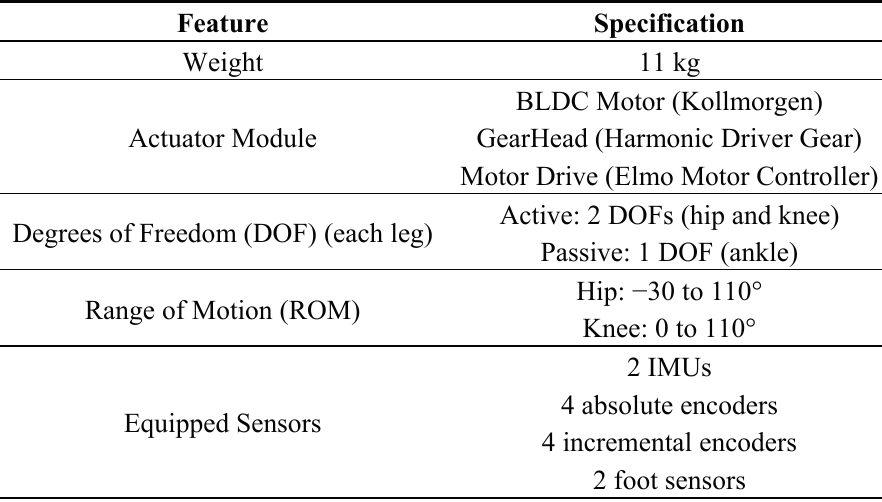
Table 1. Specification of